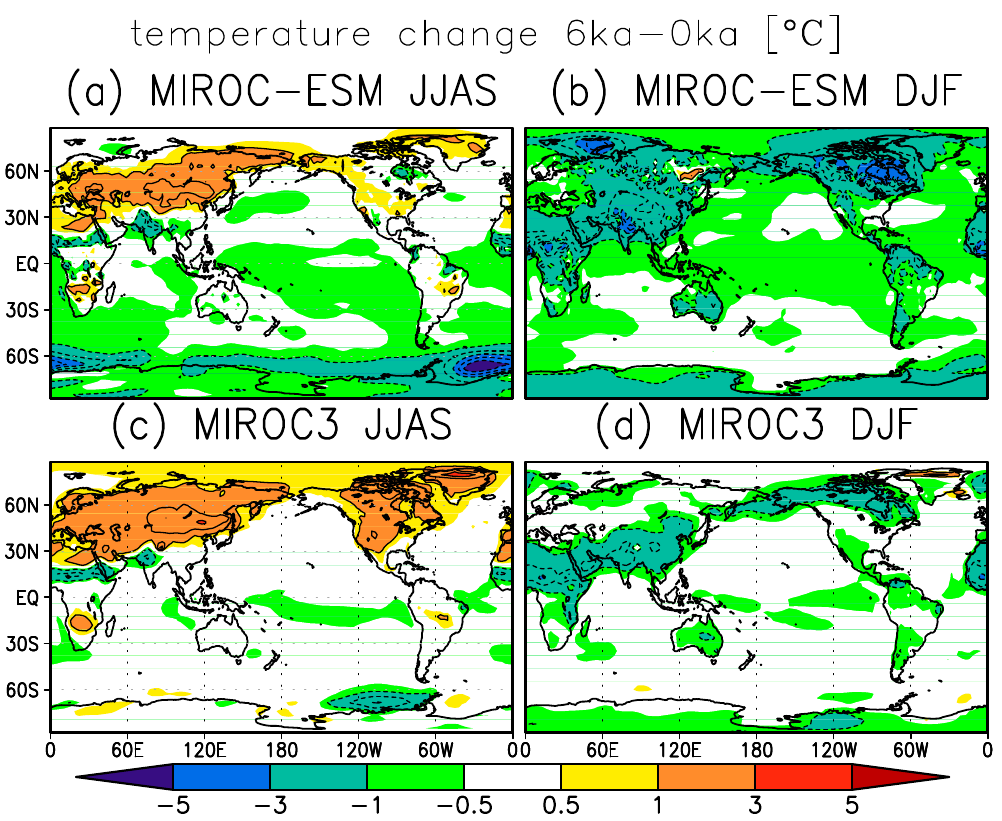
Fig. 3. 6–0ka temperature changes at a height of 2m ( ◦ C) in JJAS (left panels) and DJF (right panels) for MIROC-ESM (upper panels) and MIROC3 (lower